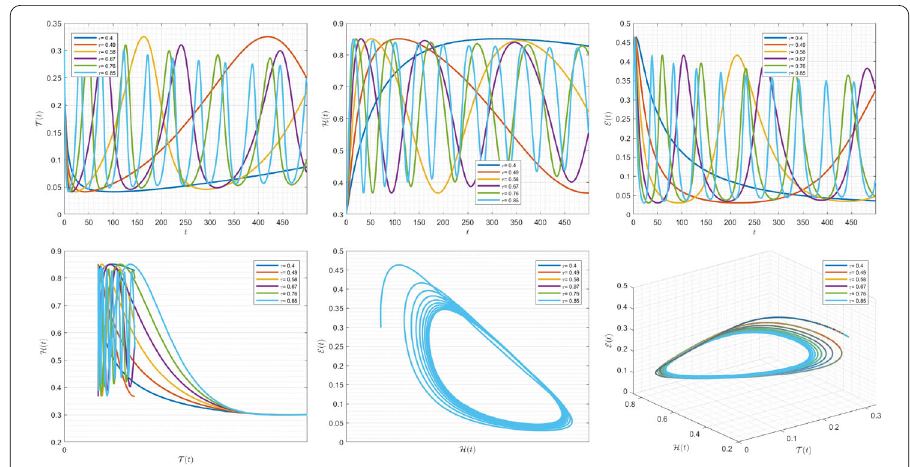
Figure 14 Simulations for solving (69) using (74) along with ( T (0), H (0), E (0)) = (0.3,0.3,0.3) and β 12 = 0.745